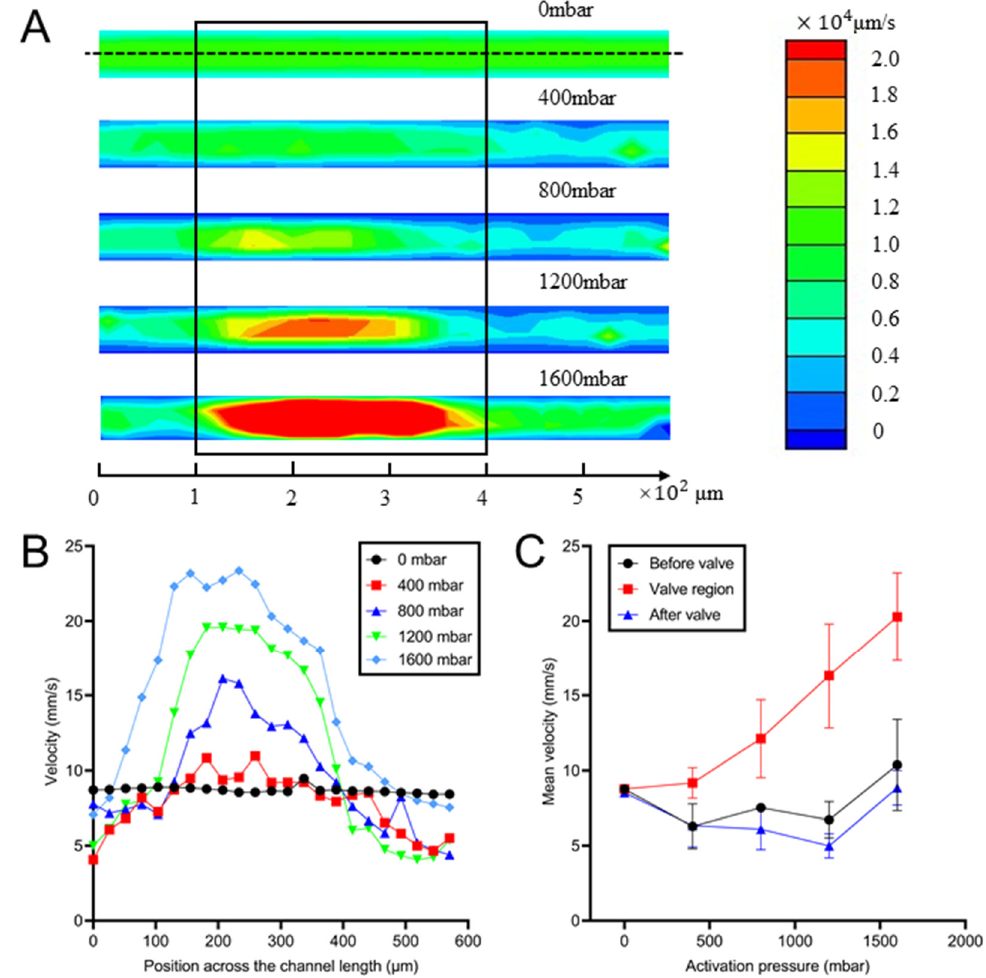
Figure 5. Characterization of flow in the valve zone. ( A ) The flow velocity contour in the valve region when the activation pressure was increased from 0 mbar to 1600 mbar. The black box represents the position of the valve. ( B ) Velocity distribution along the channel center under distinct activation pressures. ( C ) The mean velocity before, in and after the valve area at different activation pressures.